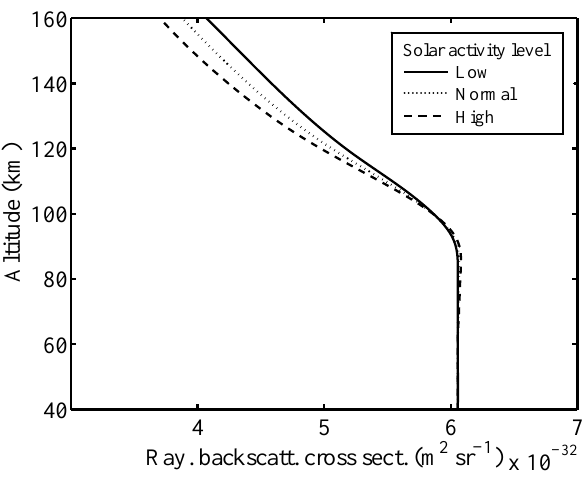
Fig. 1. Rayleigh backscatter cross section as a function of altitude. Quite, moderate and Active refer to solar activity, see text for de- tails.